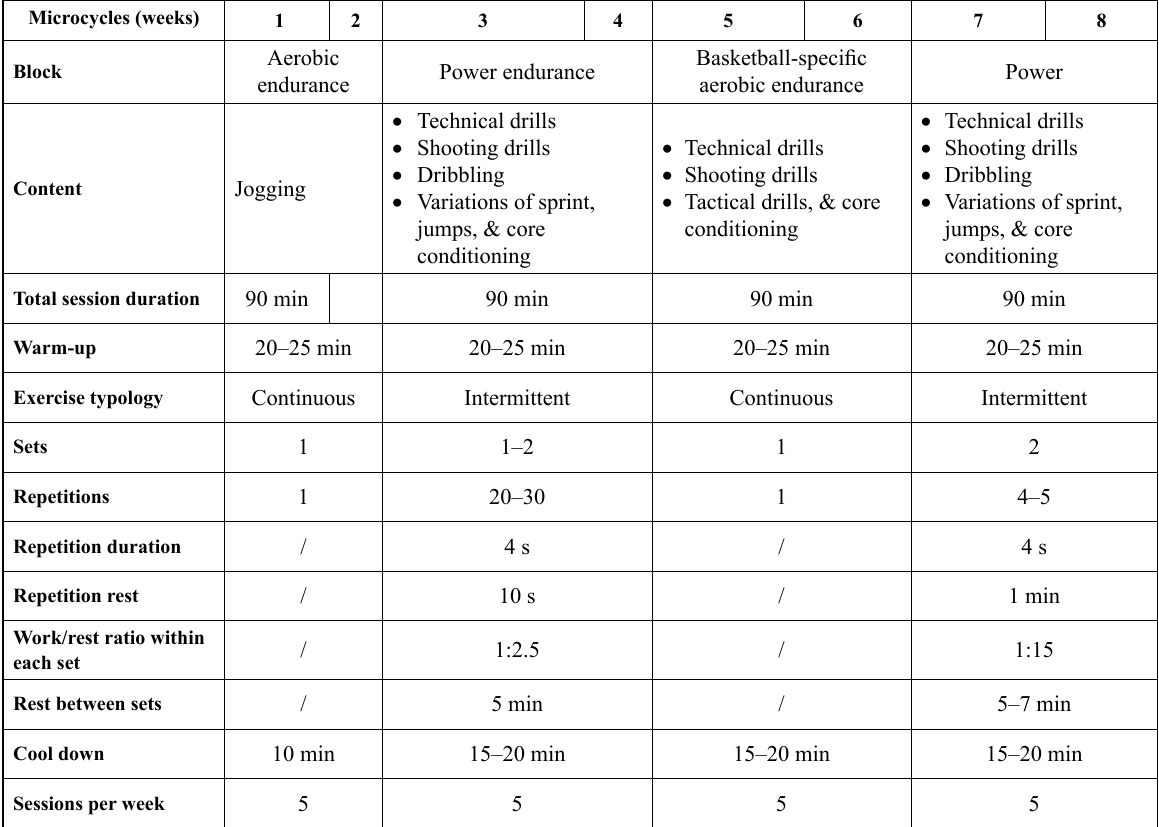
Table 2. Block periodization scheme Microcycles